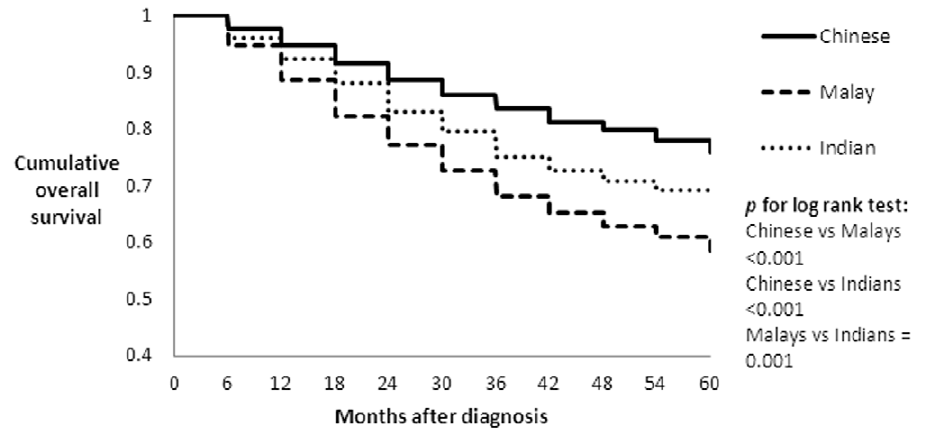
Figure 1. Cumulative overall survival by ethnicity in 5,264 South East Asian women with breast cancer.